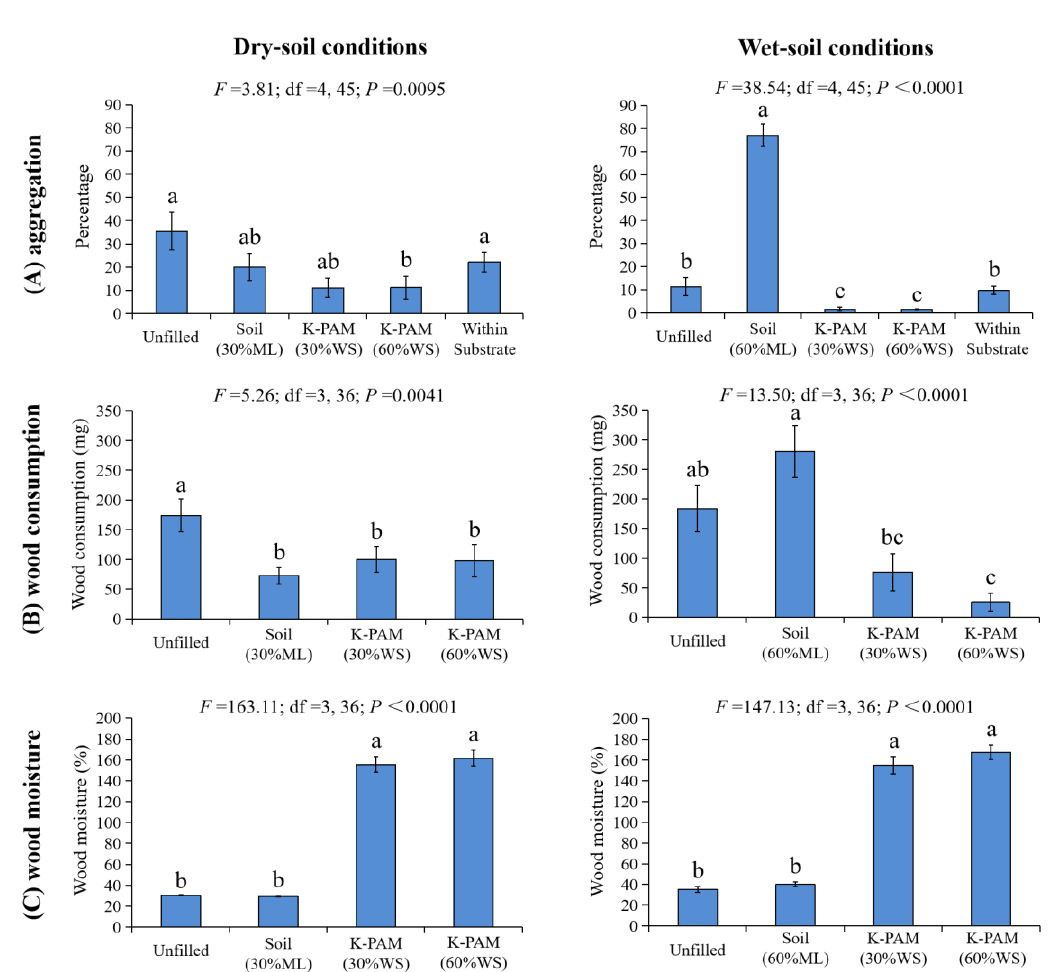
Figure 7. Results of the multiple-choice tests (under dry- or wet-soil conditions) to investigate the preference of termites to potassium polyacrylate (K-PAM) filled in the void volume of baiting containers. Percentage of termites in each location ( A ), and wood consumption ( B ) and wood moisture ( C ) in each baiting containers are presented as mean ± SE. Different letters indicate significant differences ( p < 0.05). WS represents water saturation level.